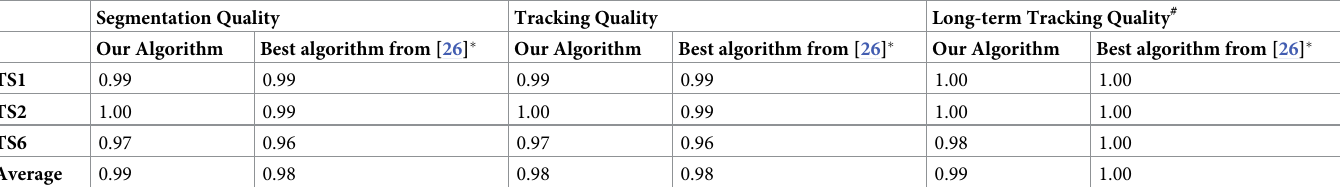
Table 8. Comparison to other